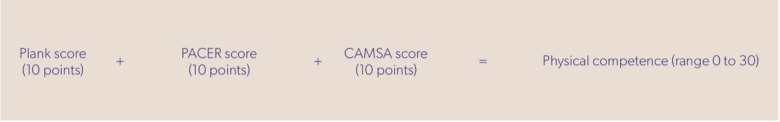
Formula for computing the physical competence score.Reprinted from www.capl-eclp.ca/capl-manual under a CC BY license, with permission from Healthy Active Living and Obesity Research Group, original copyright 2017.